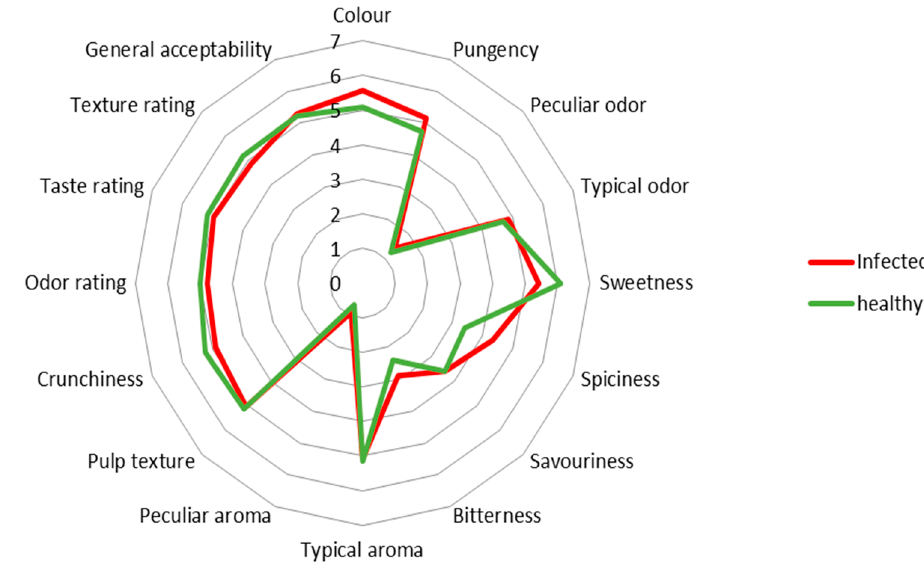
Figure 4. Spider web graph of the sensory attributes of infected (red line) and healthy (green line) onion bulbs.